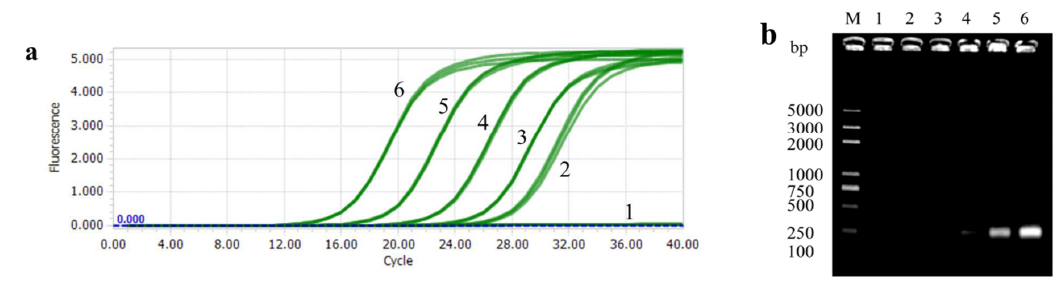
Figure 3. Sensitivity tests for the plasmid standard template. ( a ) The amplification curve of PTP2-qPCR. ( b ) Agarose electrophoresis of conventional PCR. 1: Negative control, 2–5: 1.0 × 10 1 to 1.0 × 10 5 copies/μL plasmid template.